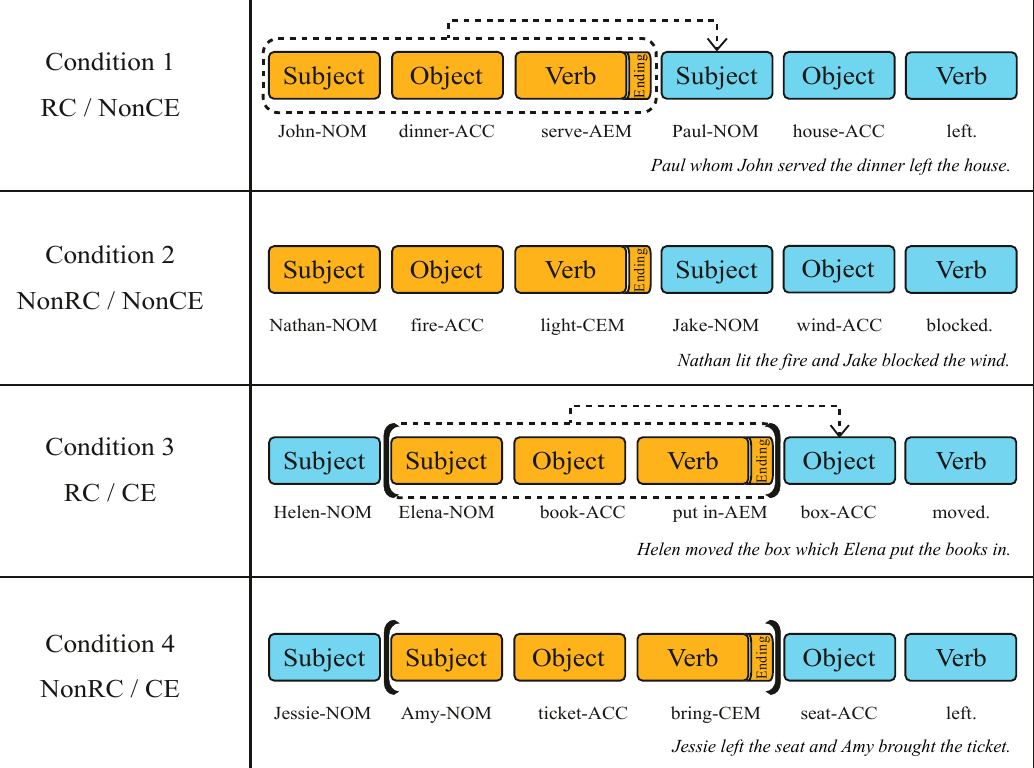
Figure 1. Four different conditions of Experiment 1. Blue and orange shades represent the main clause and the subordinate clause, respectively. Ending markers (an AEM or CEM) are shown as “Ending” only after the first verb for easy explanation here. Case markers attached to each subject, object, and verb were shown throughout the actual experiment. Dotted arrows indicate the formation of an RC between clauses. Brackets surrounding subordinate clauses indicate CE. Condition 1 has an RC in two clauses, with the first clause modifying the subject of the second clause (Paul-NOM). Condition 2 has two clauses conjoined by a CEM without an RC or CE. Condition 3 has both an RC and CE. In this case, the subordinate clause (a structure shaded in orange) is merged with the following main object (box-ACC). Condition 4 has the only CE with a CEM. Here we have provided English names to aid understanding of the subjects; Korean names were used in the actual experiment. Abbreviations: RC (relative clause), CE (center embedding), AEM (adnominalizing ending marker), CEM (conjunctive ending marker), NOM (nominative case marker), ACC (accusative case marker).